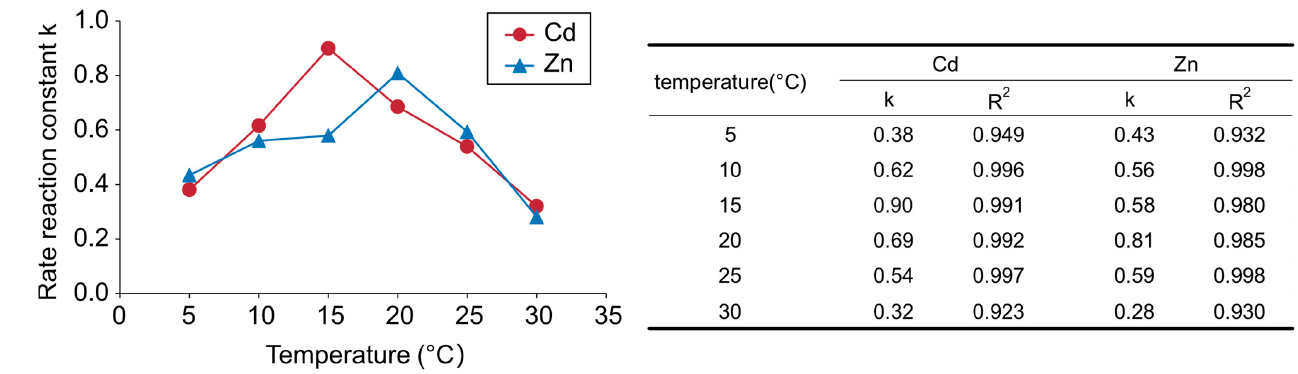
Figure 5. Change in the reaction rate constant for Cd and Zn removal from solution by A. halleri ssp. gemmifera.